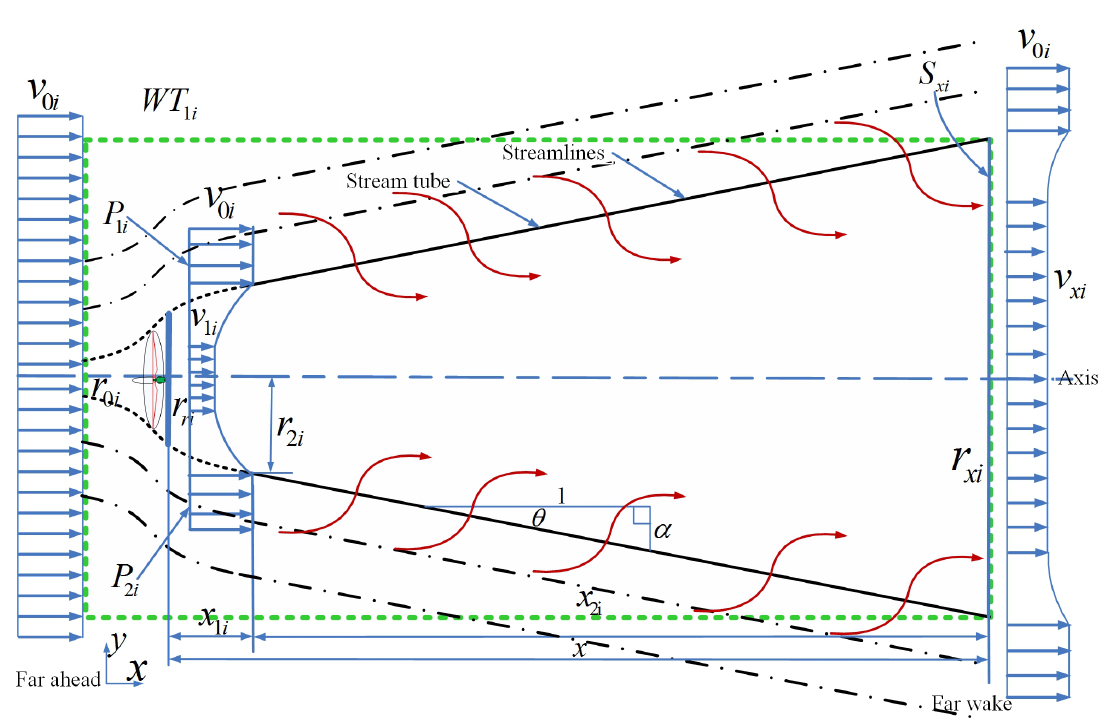
Figure 3. The portrait of Frandsen Generalized Wake Model (FGWM) with stream tube